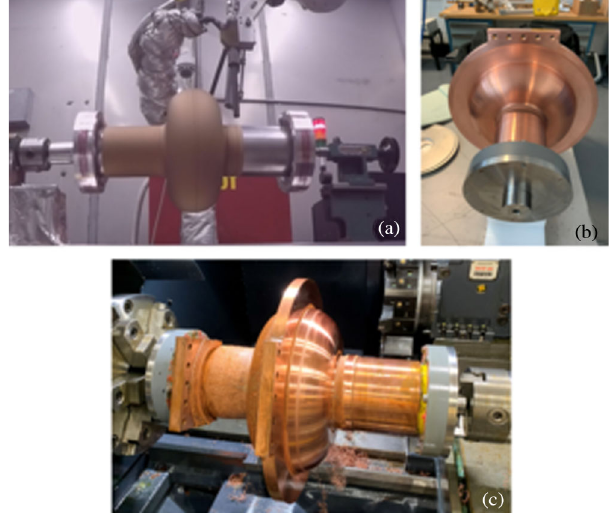
spray.FIG. 11. Pictures taken during the fabrication of the Cu structure on the outer cavity surface: during cold-spray (a), during fitting of the equator ring on the Cu layer after the first electroplating and machining (b) and during the final machining